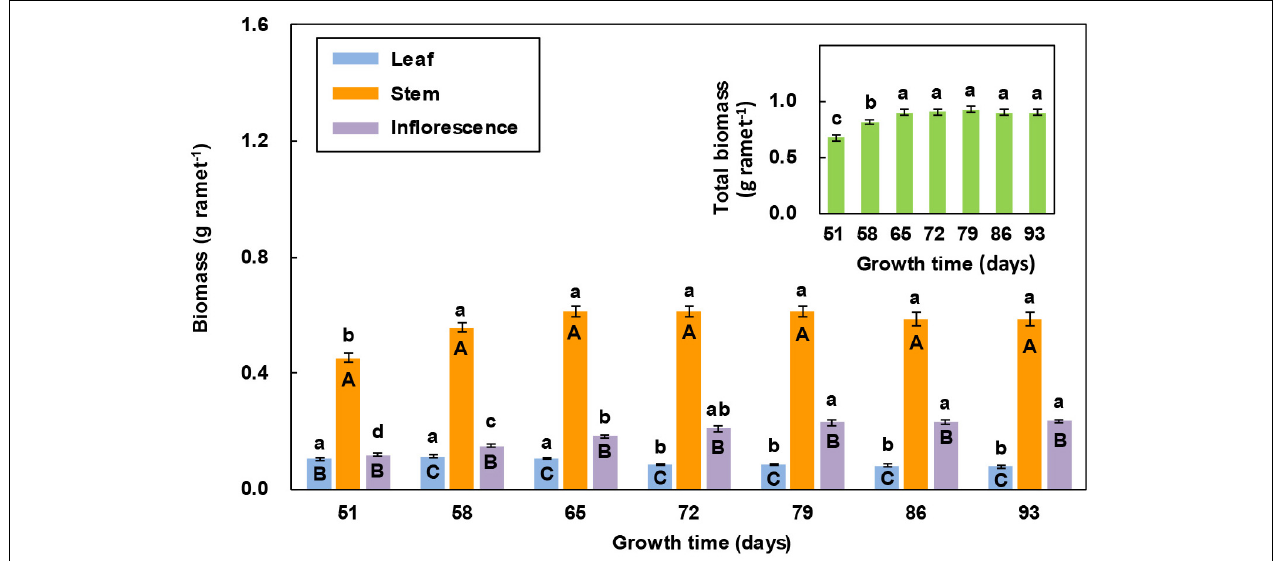
FIGURE 4 | Comparison of the biomass of three organs of reproductive ramets over time (means ± SE, n = 10) in Leymus chinensis . Different lowercase letters indicate significant differences ( P < 0.05) between the growth times for the same organ; different capital letters indicate significant differences ( P < 0.05) between the organ types for the same growth time. The total biomass of three organs is presented as an inset figure. The dates corresponding to the seven growth times are May 26, June 2, June 9, June 16, June 23, June 30, and July 7 in